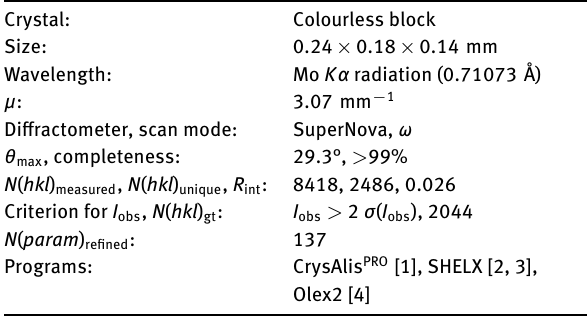
Table 2: Fractional atomic coordinates and isotropic or equivalent isotropic displacement parameters (Å 2 ).